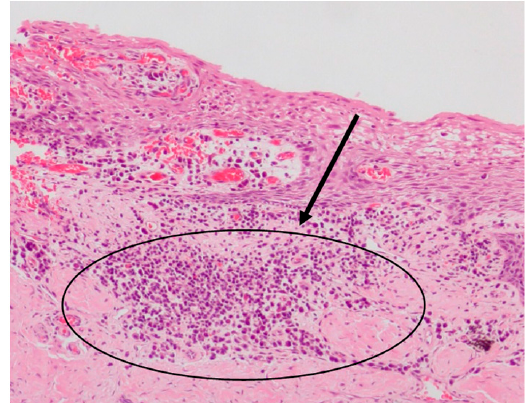
Figure 4. Light microscopy of 4 µm sections of the sulcular epithelial tissue of a patient with APE and stained with haematoxylin and eosin. In the circled area, an obvious chronic inflammatory plasma cell infiltrate is present, at a magnification of 10×.